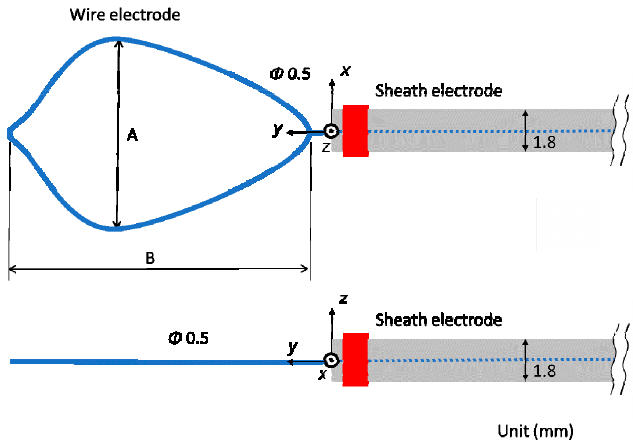
Figure 2. Schematic diagram of the proposed microwave snare.